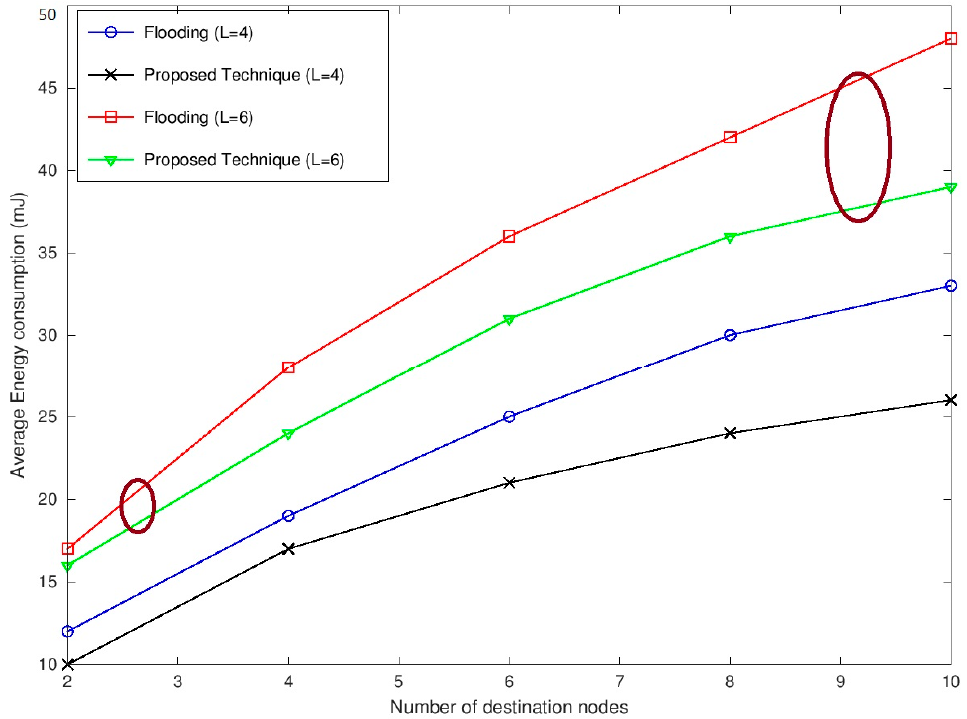
Figure 5. Average energy consumption versus the number of destination of nodes.